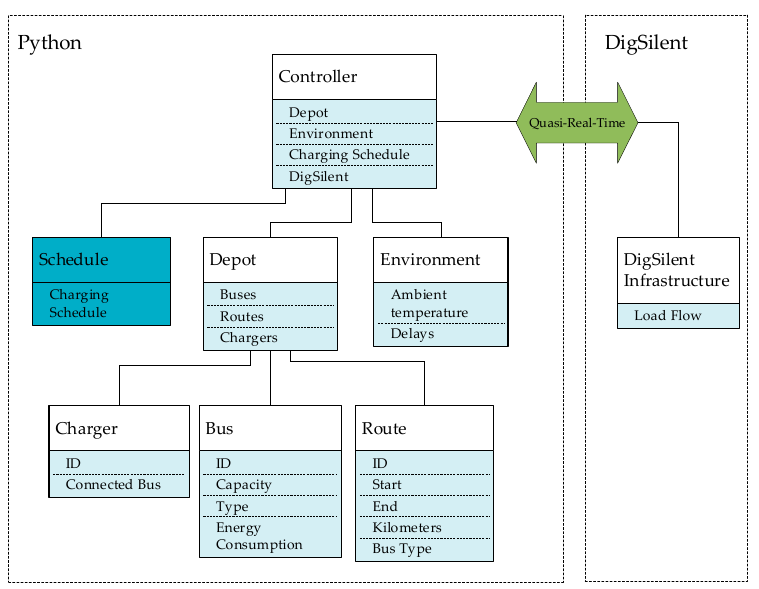
Figure 2. Cosimulation process with Python and Power Factory.